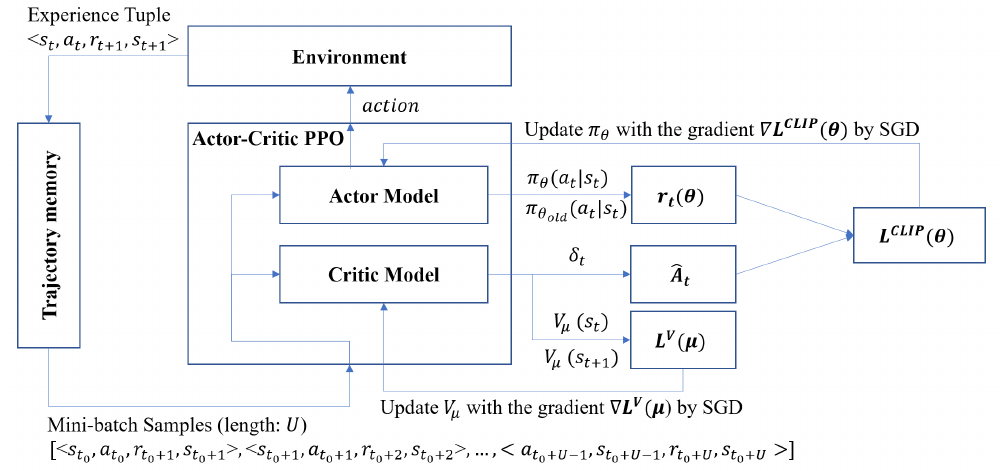
Figure 3. The actor–critic proximal policy optimization (Actor–Critic PPO) algorithm